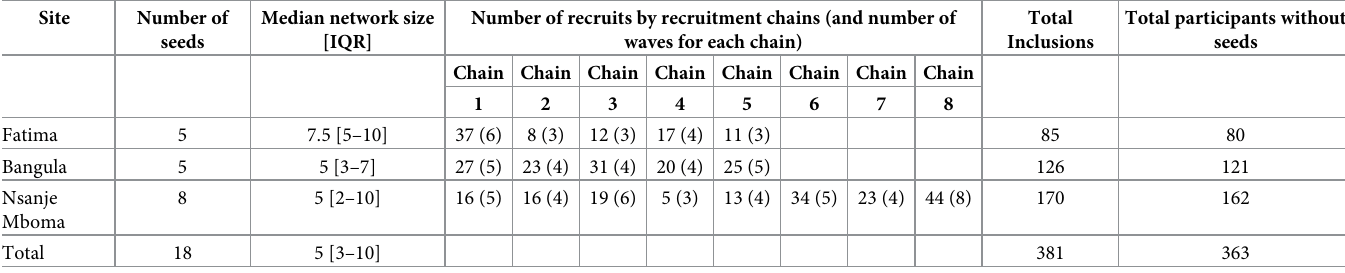
Table 1. Number of recruits and number of RDS recruitment chain by sites. Site Number of